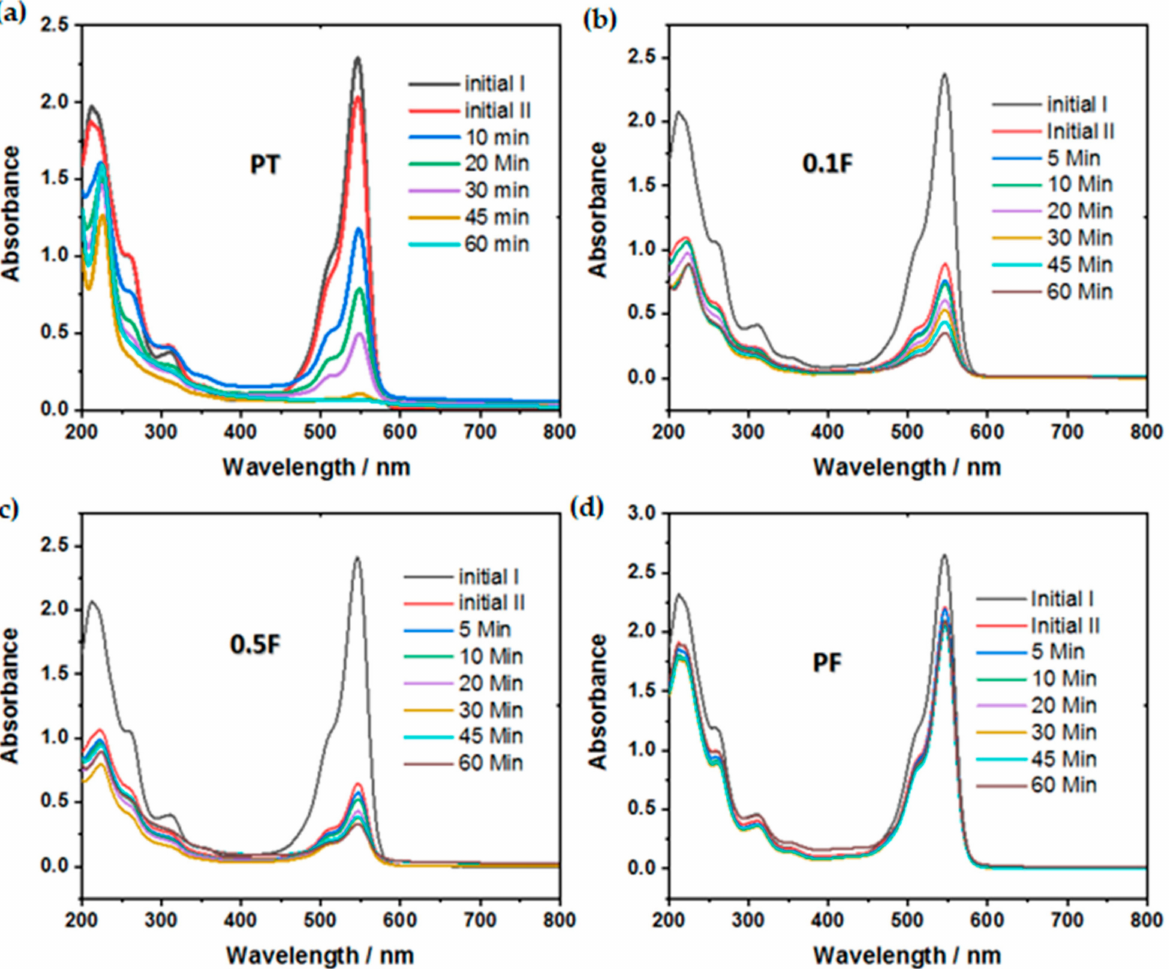
Figure 9. UV-Vis absorbance of the photocatalytic degradation of 100 ppm of Rose Bengal dye (60 min) over 1 g L − 1 of ( a ) PT, ( b ) 0.1F, ( c ) 0.5F and ( d ) PF